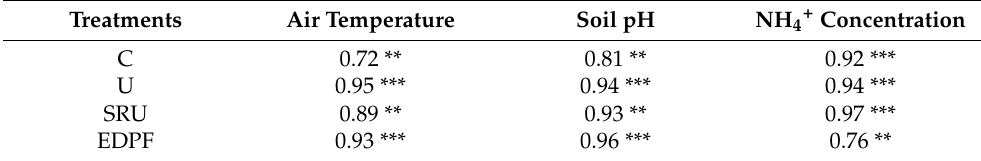
Table 5. Correlation between NH 3 fluxes and air temperature, soil pH, and NH 4+ concentration. Treatments